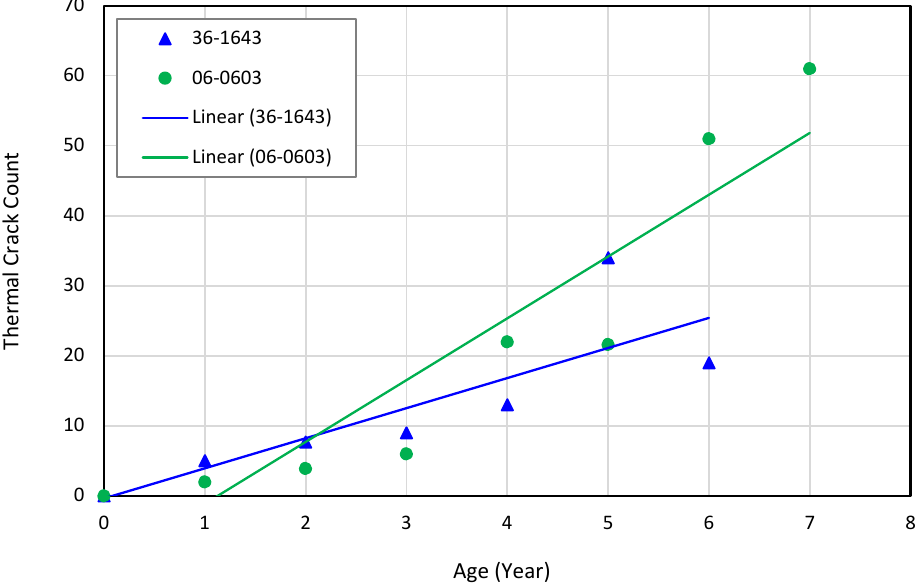
Figure 12. Thermal crack count on the LTPP test sections with high structural capacity.